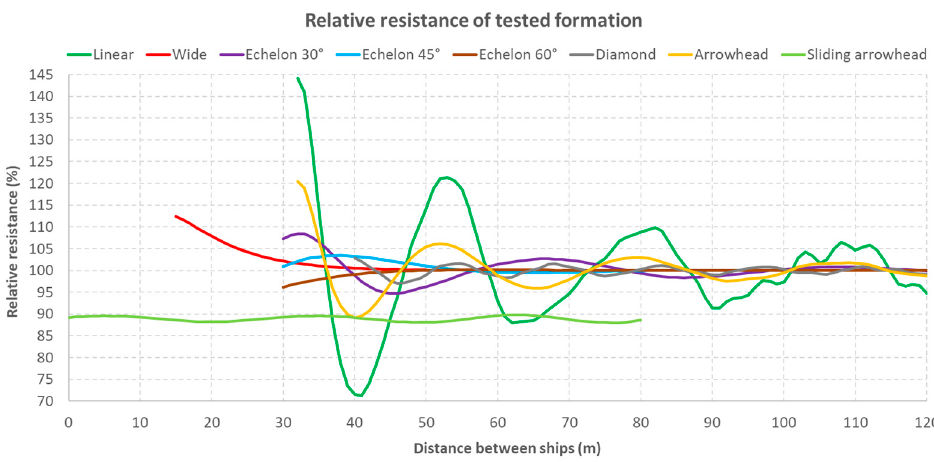
Figure 15. Relative value of total drag as a function of ship distance for a given formation in the entire speed